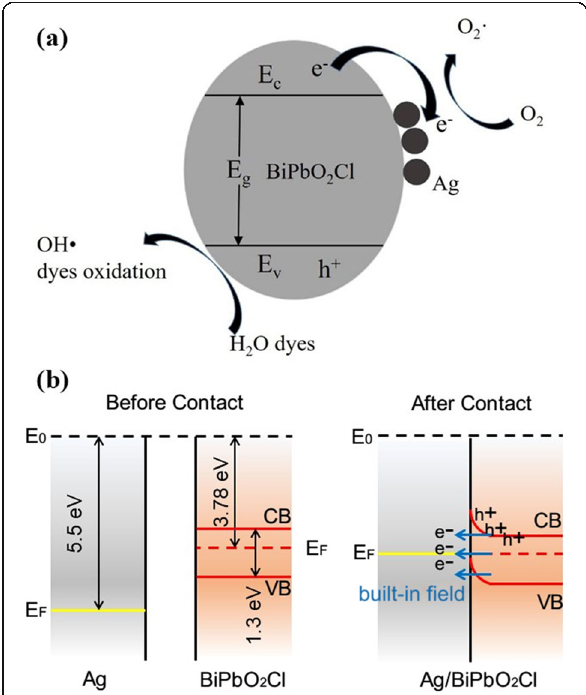
Fig. 6 a Mechanistic illustration of Ag/BiPbO 2 Cl composites for photocatalytic activity. b Band structure at the interface of Ag and BiPbO 2 Cl. The data used for BiPbO 2 Cl are from reference